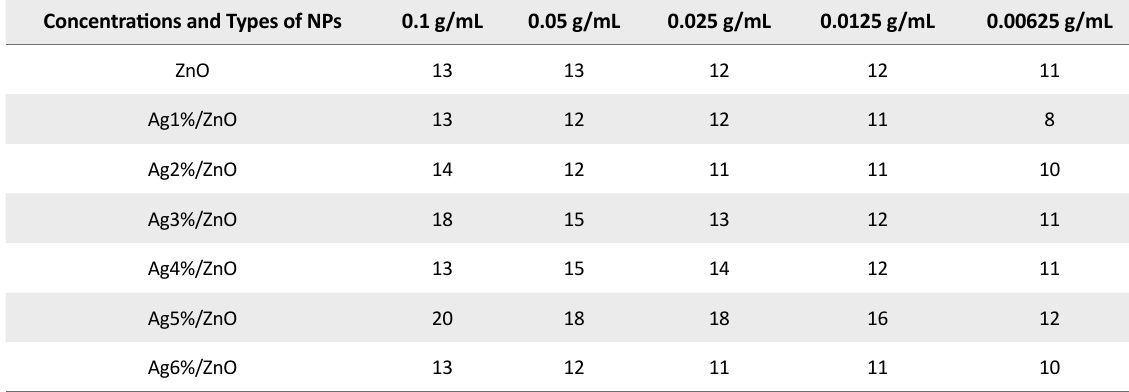
Table 3. Mean diameter of zone of inhibition (mm) against Staphylococcus aureus at different concentrations Concentrations and Types of NPs 0.1 g/mL